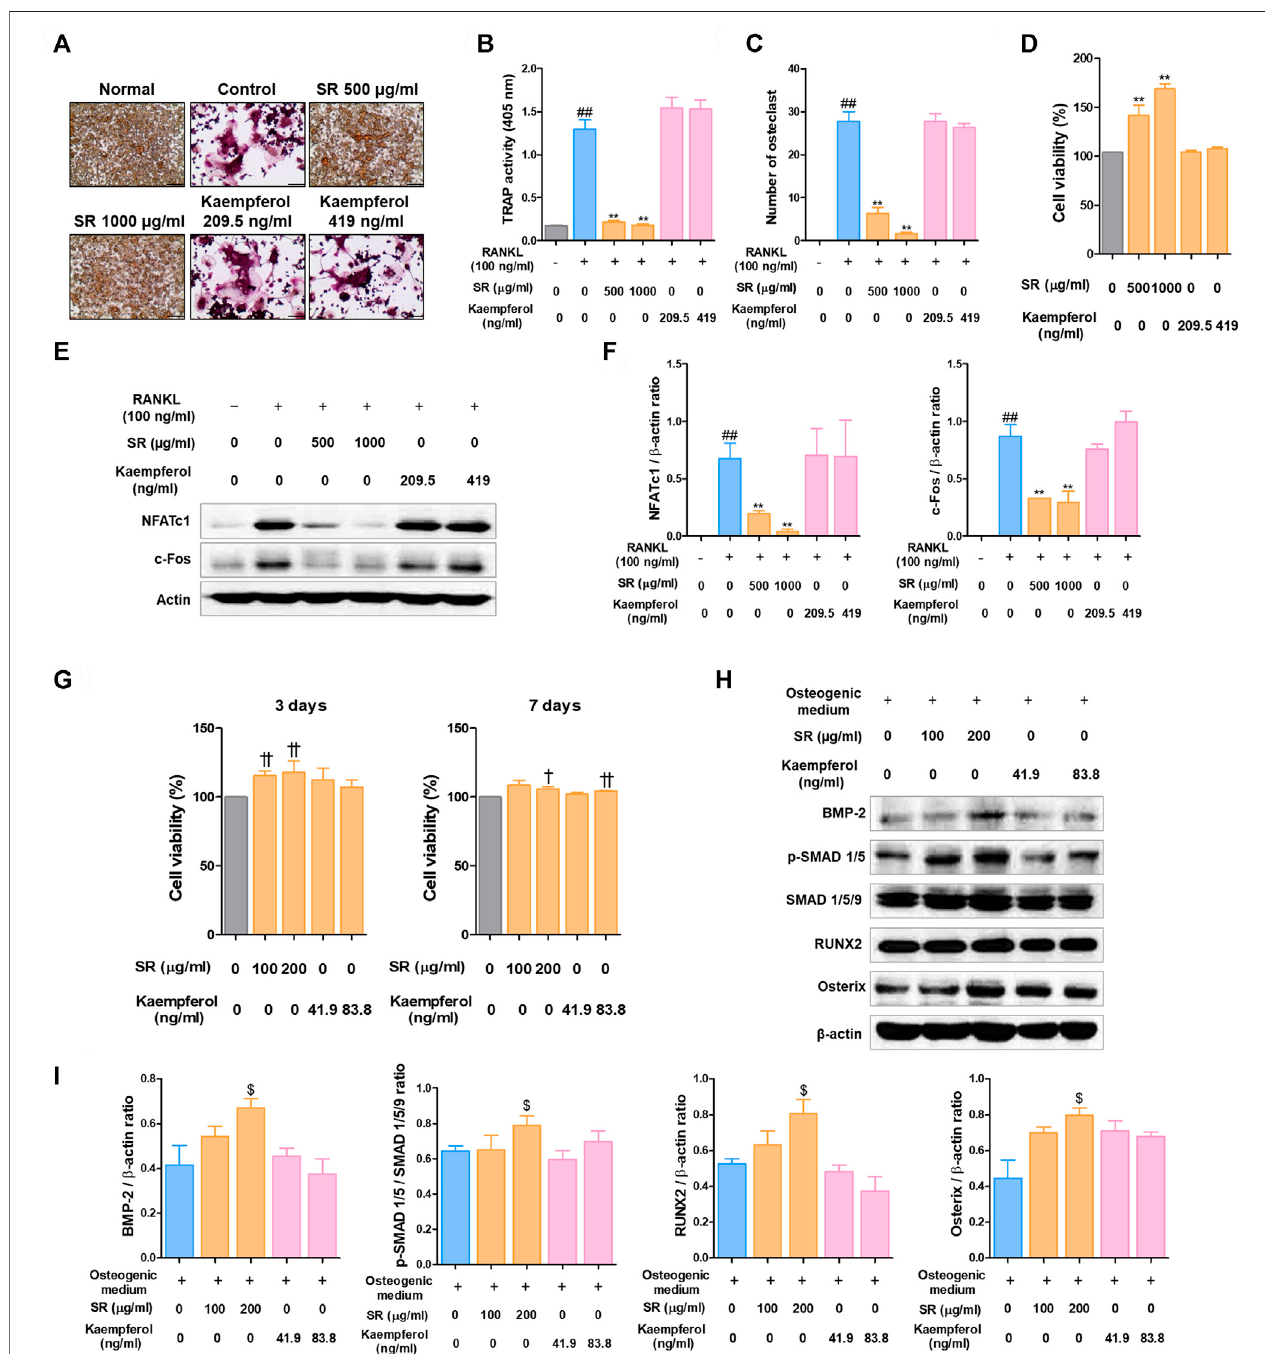
FIGURE 12 | Comparative analysis of pharmacological effects of SR and kaempferol on the differentiation of osteoclasts and osteoblasts. (A) TRAP-positive cells were stained using a TRAP kit. (B) TRAP activity was measured using an ELISA reader. (C) A number of TRAP-positive cells with > 3 nuclei were counted using an invertedmicroscope (magni fi cation, × 100). (D) RAW 264.7 cellviabilitywas measured using aCCK-8 assaykit. (E) Proteinexpression levels ofNFATc1and c-Fos were measured by western blotting. (F) The bands were normalized to that of β -actin, which was used as a loading control. (G) MC3T3-E1 cell viability was analyzed by CCK-8 assays at 3 and 7 days. (H) Protein expression levels of BMP-2, p-Smad 1/5, RUNX-2 and Osterix were measured by western blotting. (I) BMP-2, RUNX-2 and Osterix levels were normalized to that of β -actin. p-Smad 1/5 levels was normalized to that of Smad 1/5/9. Data are presented as the mean ± SD of three independent experiments.Statisticalanalysiswasperformedusingone-wayANOVAfollowedbyDunnett ’ sposthoctest. ## p < 0.01vs.thenormalgroup(untreatedcells,RAW264.7 cells); * p < 0.05, ** p < 0.01 vs. the RANKL only treatment group. † p < 0.05, †† p < 0.01 vs. the normal group (untreated cells, MC3T3-E1 cells); $ p < 0.05 vs. the osteogenic medium-treated cells.